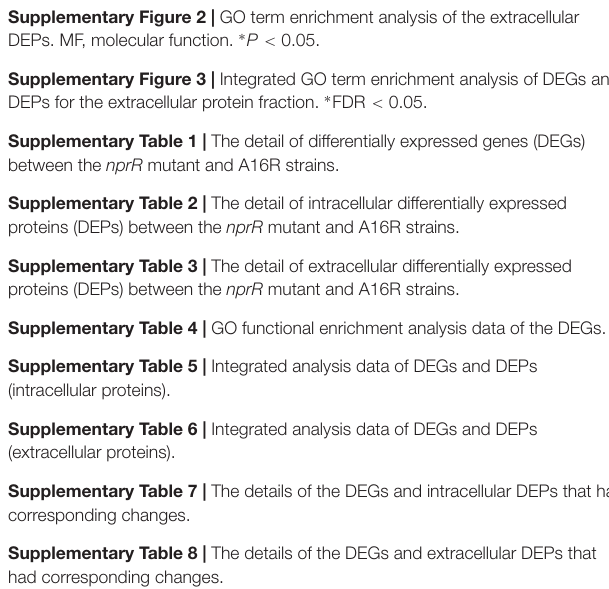
Supplementary Figure 1 | Summary of the RNA-seq analyses of the nprR deletion mutant and A16R strains. (A) Venn diagram, (B) distribution density analysis, and (C) correlation analysis showing the overlap in gene expression between the two strains. Supplementary Figure 2 | GO term enrichment analysis of the extracellular DEPs. MF, molecular function. ∗ P < 0.05. Supplementary Figure 3 | Integrated GO term enrichment analysis of DEGs and DEPs for the extracellular protein fraction. ∗ FDR < 0.05. Supplementary Table 1 | The detail of differentially expressed genes (DEGs) between the nprR mutant and A16R strains. Supplementary Table 2 | The detail of intracellular differentially expressed proteins (DEPs) between the nprR mutant and A16R strains. Supplementary Table 3 | The detail of extracellular differentially expressed proteins (DEPs) between the nprR mutant and A16R strains. Supplementary Table 4 | GO functional enrichment analysis data of the DEGs. Supplementary Table 5 | Integrated analysis data of DEGs and DEPs (intracellular proteins). Supplementary Table 6 | Integrated analysis data of DEGs and DEPs (extracellular proteins). Supplementary Table 7 | The details of the DEGs and intracellular DEPs that had corresponding changes. Supplementary Table 8 | The details of the DEGs and extracellular DEPs that had corresponding